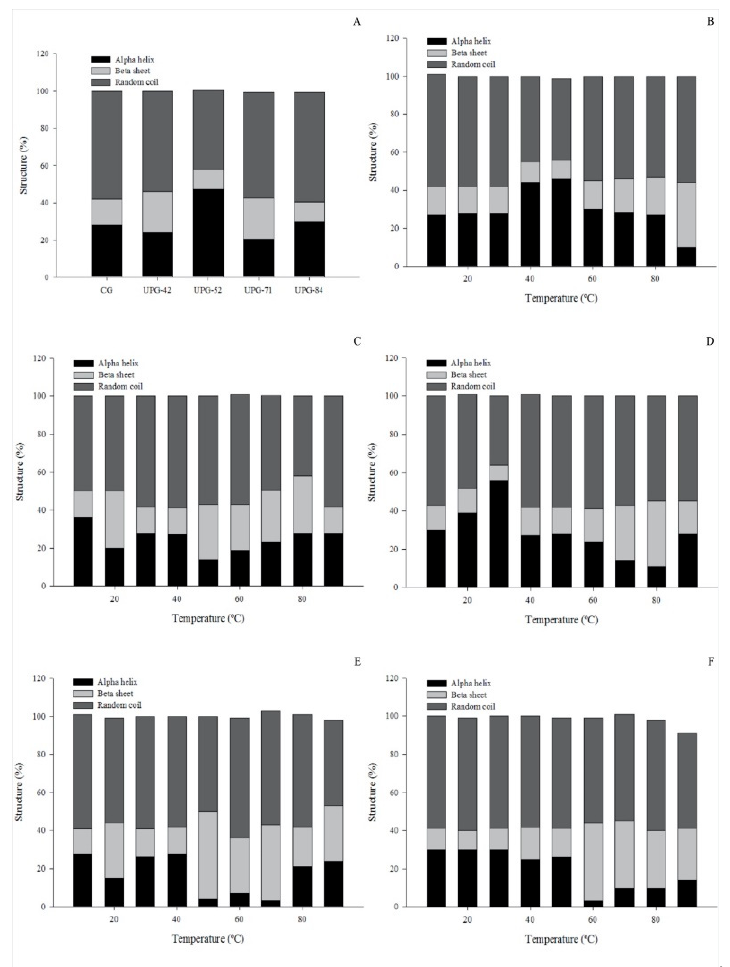
Figure 2. Secondary structure composition of ultrasound pulsed tilapia ( Oreochromis niloticus ) skin gelatin. ( A ): Secondary structure composition of gelatins at 25 °C. ( B – F ): Secondary structure composition in a temperature range of 10 to 90 °C of the control gelatin (CG), ultrasound-pulsed gelatin (UPG)-42, UPG-52, UPG-71, and UPG-84, respectively.